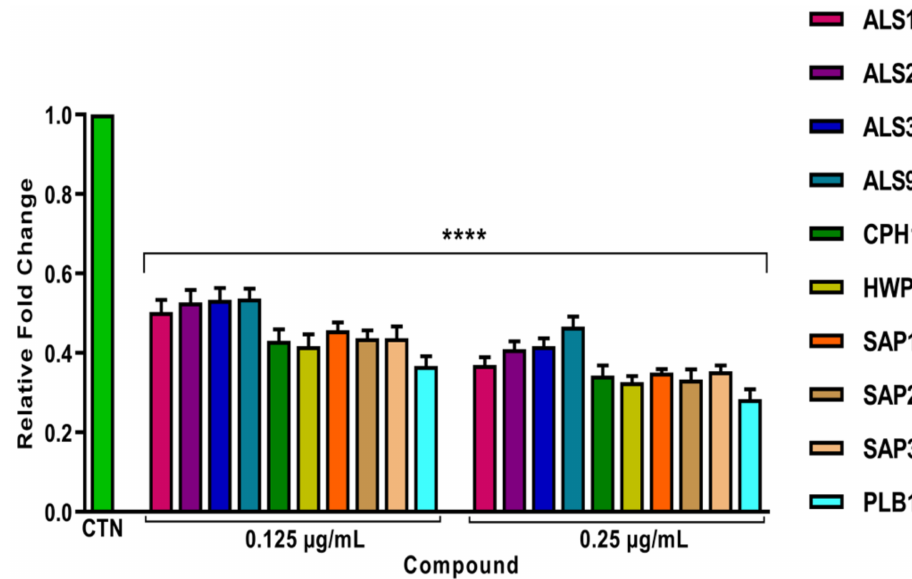
Figure 16. Effect of bimetallic Ag-Cu NPs at subinhibitory concentrations ( 1 / 4 × MIC and 1 / 2 × MIC) on the expression of genes involved in pathogenicity in C. albicans SC5314. Relative gene expression was calculated after normalization to housekeeping genes ( ACT1 , PMA1, and RPP2B ). Unexposed cells (CTN) were considered as a negative control. **** p value <